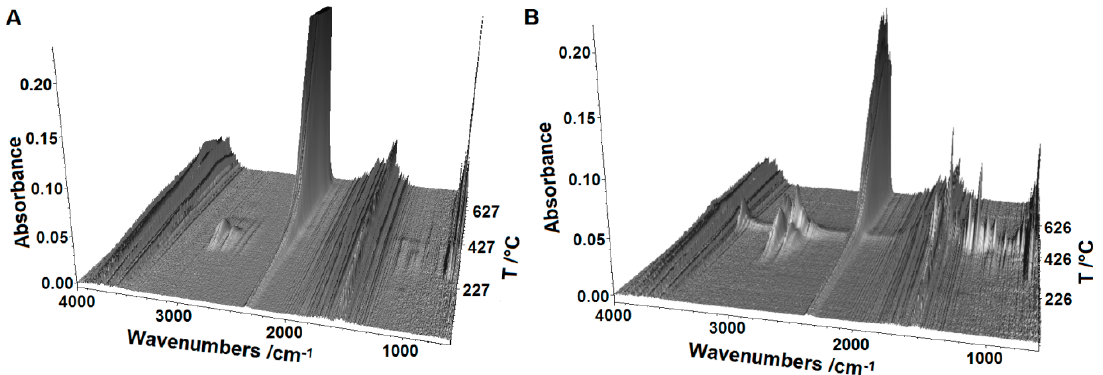
Figure 10. 3D diagram of FTIR spectrum of gases evolved during thermal decomposition D2AAK1_3 in air ( A ) and nitrogen ( B ) atmospheres.